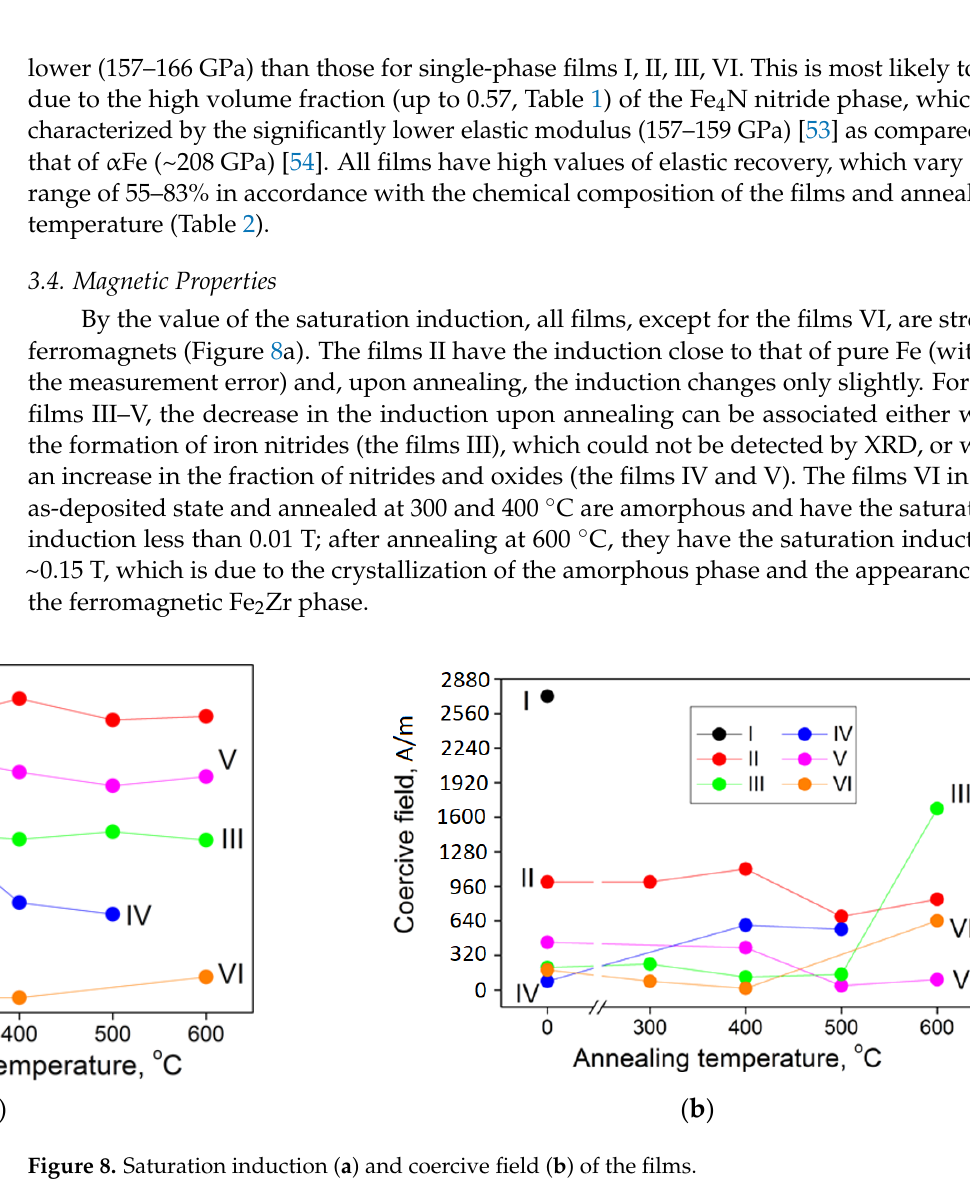
other (not shown in order to Figure 9 was not cluttered